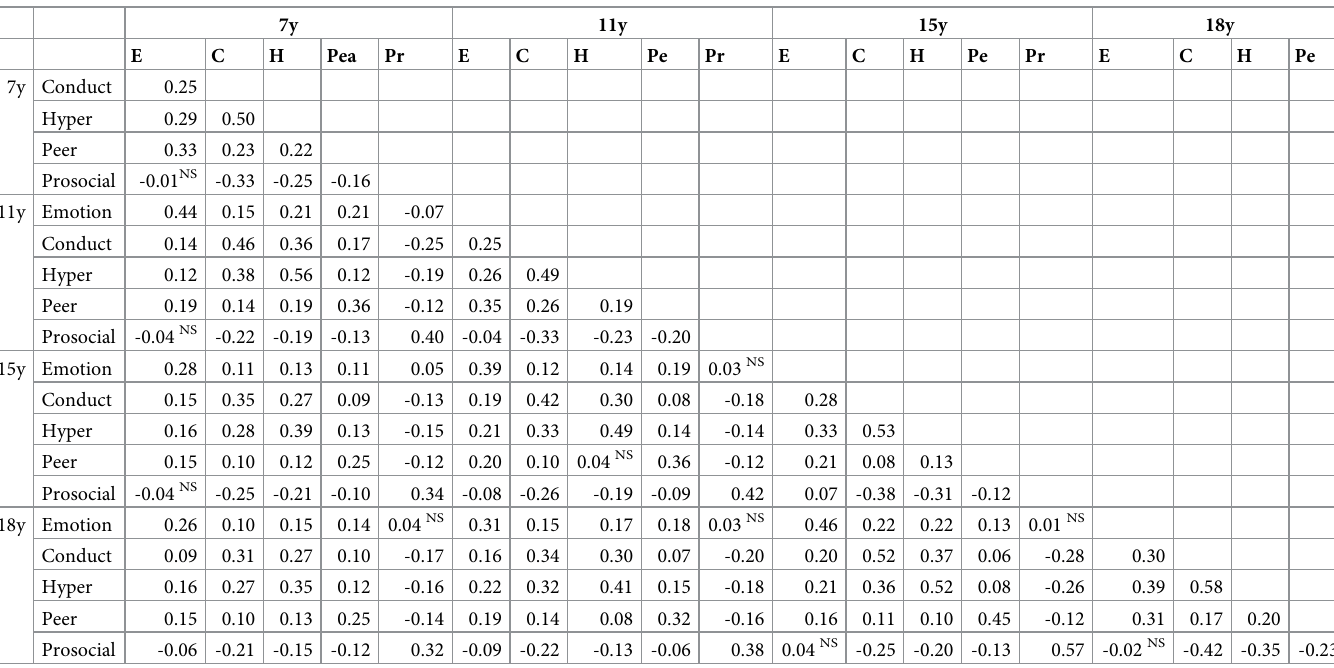
Table 3. Spearman rank correlations between SDQ subscales over